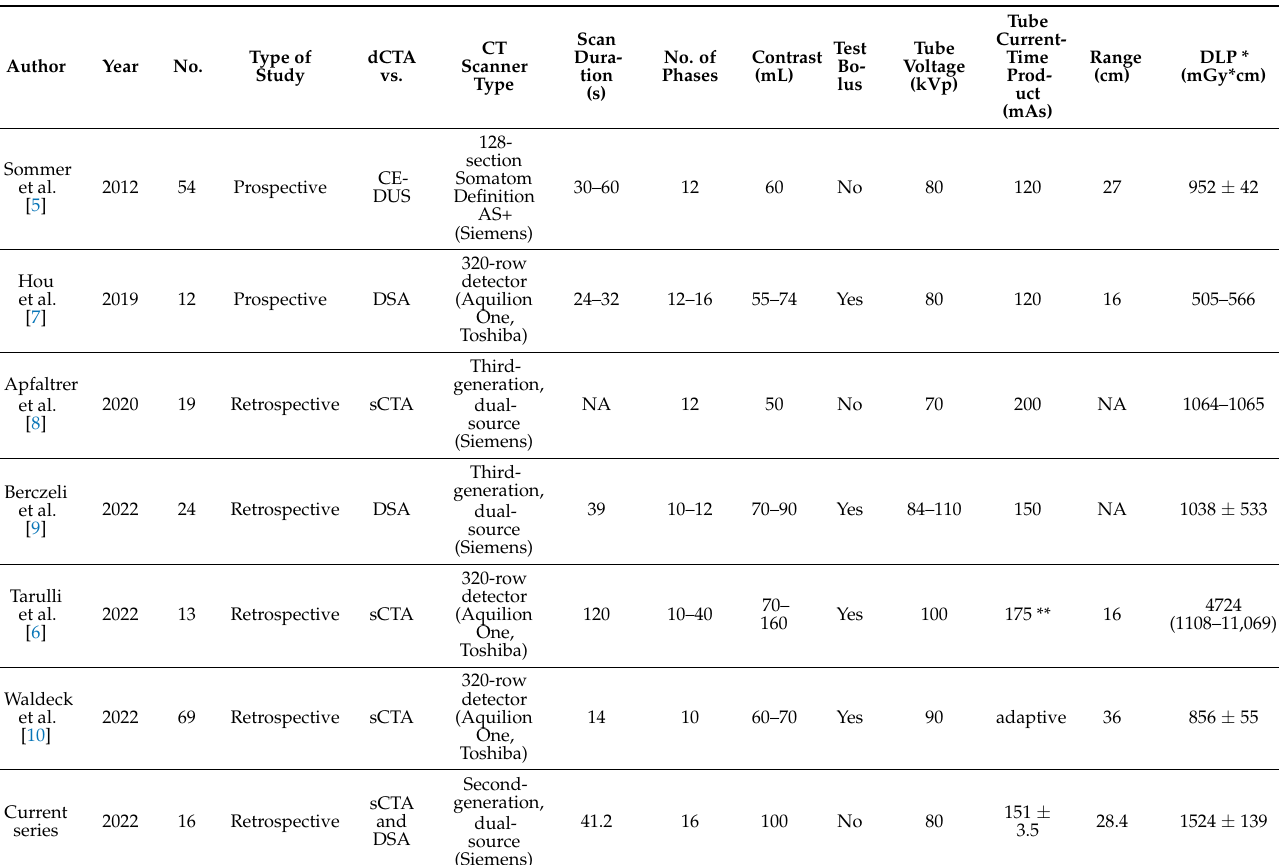
Table 3. Overview of the series that reported on conventional imaging vs. dCTA. DSA = digital subtraction angiography, CE-DUS = contrast-enhanced duplex ultrasound, sCTA = standard computed tomography angiography, and dCTA = dynamic computed tomography angiography. * Dynamic CTA-protocol without additional venous phase. ** 350 mAs with 0.5 s per acquisition.